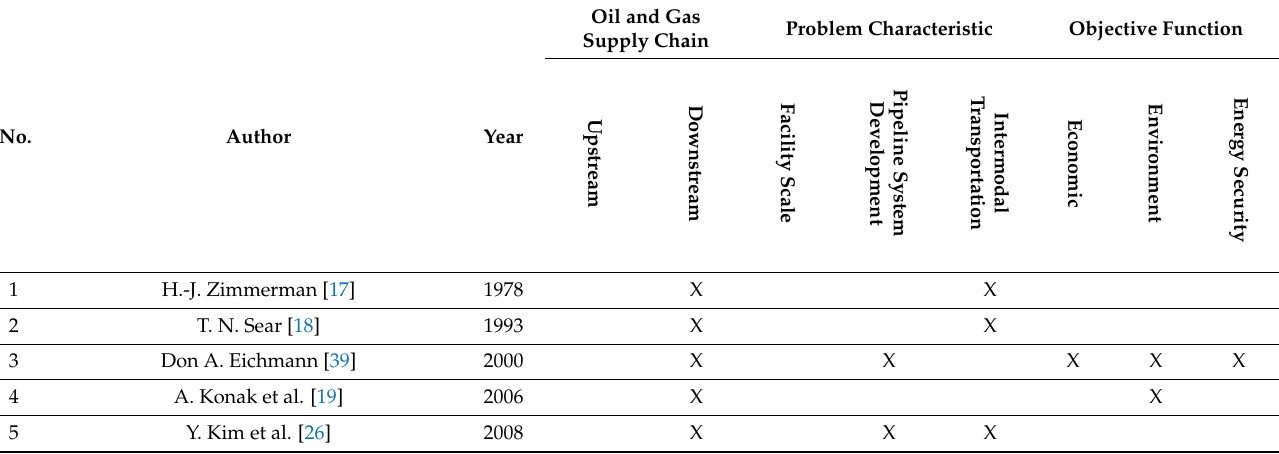
Table 1. Related research problem